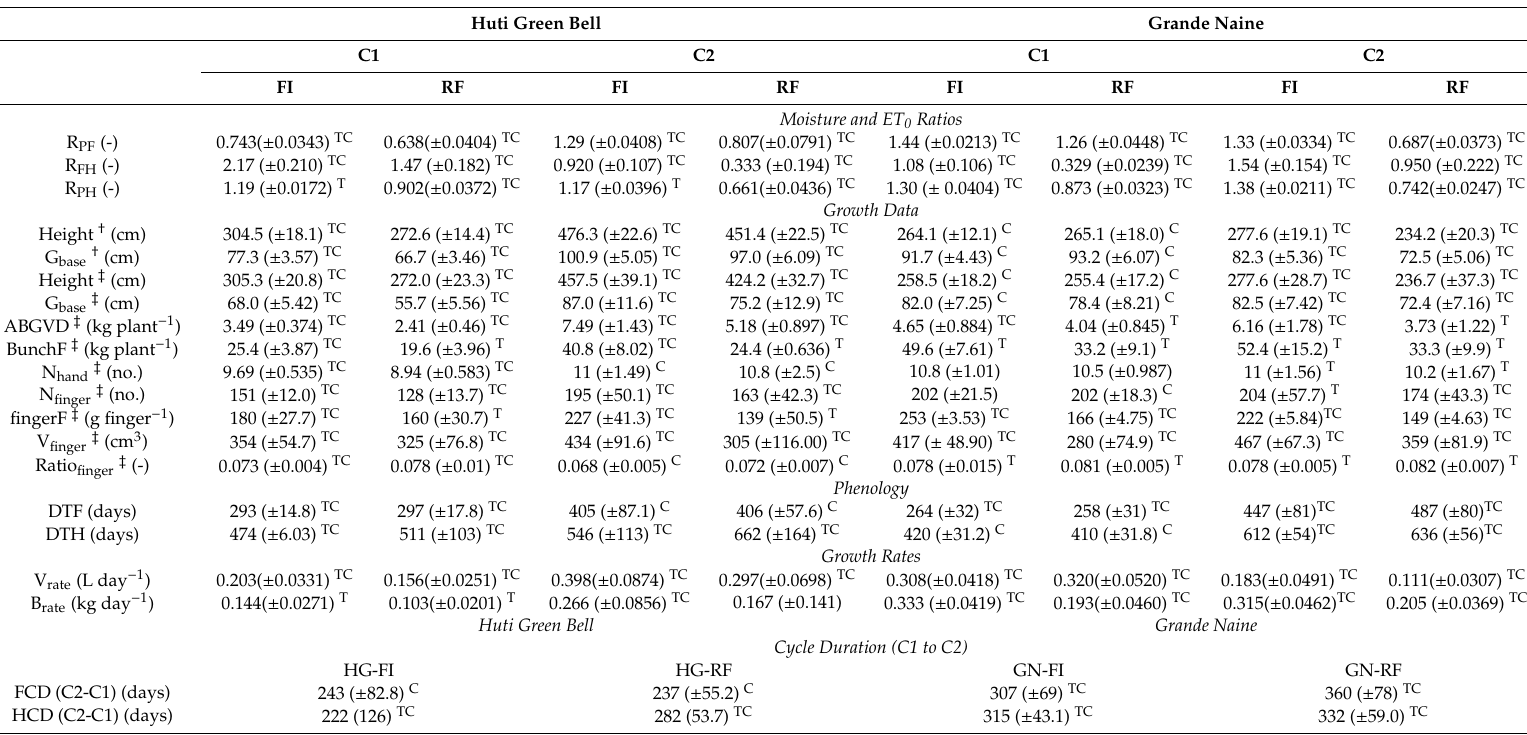
Table 2. Descriptive plant growth parameters at flowering or harvest for plant growth cycles (Cycle 1, C1 and Cycle 2, C2) and irrigation treatments (full irrigation, FI and rainfed, RF) noted as mean ( ± standard deviation) of cultivars Huti Green Bell (HG) and Grande Naine (GN) Huti Green Bell Grande